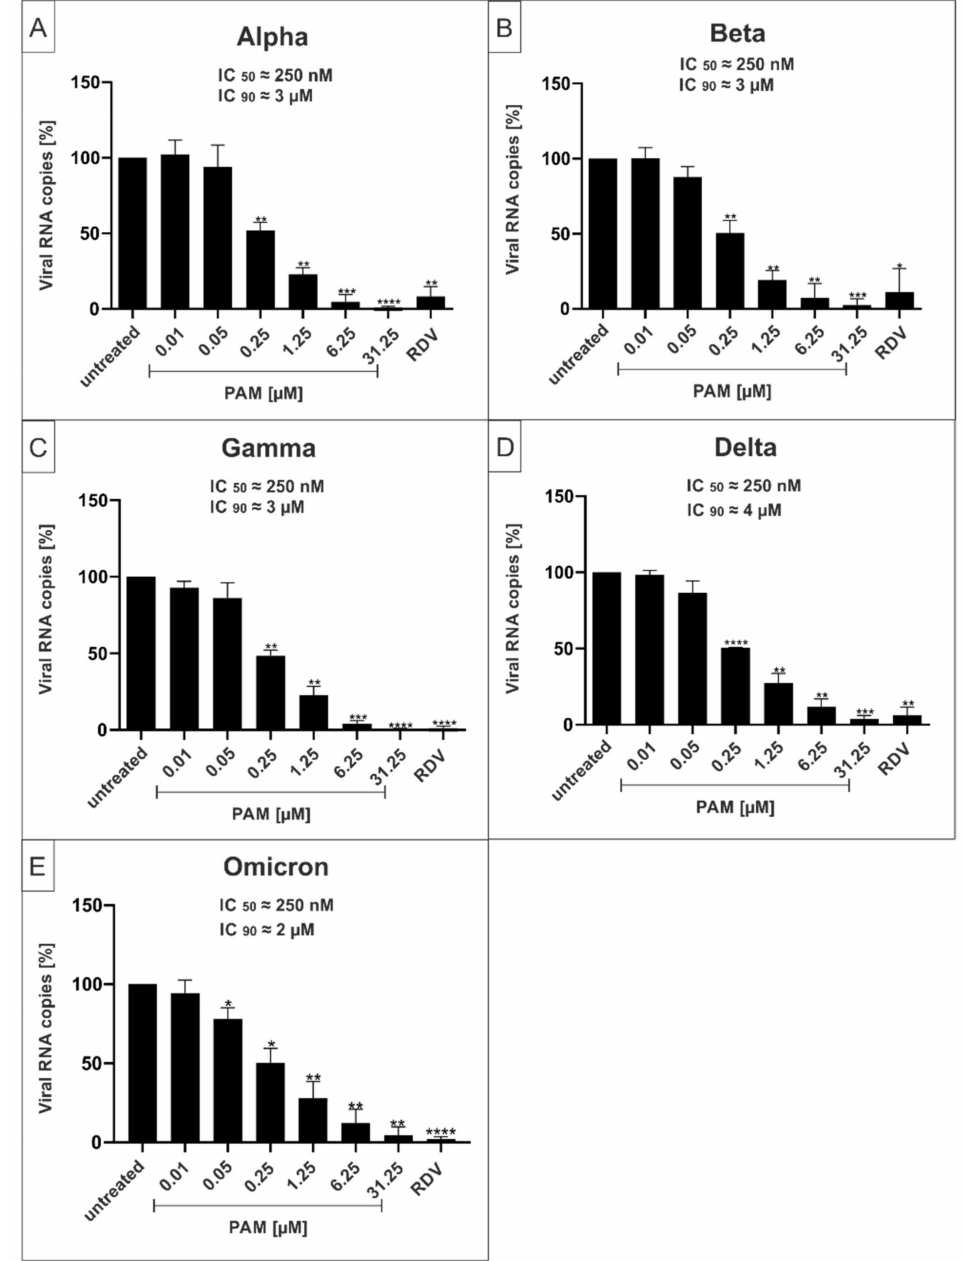
Figure 5. PAM inhibits replication of the SARS-CoV-2 Variants of Concern (VoCs) Alpha, Beta, Gamma, Delta, and Omicron with comparable antiviral efficacy. Calu-3 cells were infected with clinical isolates of the SARS-CoV-2 VoCs Alpha ( A ), Beta ( B ), Gamma ( C ), Delta ( D ), and Omicron ( E ) at a MOI of 2 × 10 − 2 . One hour after infection and removal of input virus, cells were treated with the indicated concentrations of PAM; 1 µ M RDV was included as a positive control. Cell culture supernatants were harvested at 3 dpi. The virions were purified and analyzed by qRT-PCR. Data represent means of three independent experiments ± standard deviation (* p < 0.05, ** p < 0.0089, *** p < 0.0008, and **** p < 0.0001) using a One sample t test, where each value is compared to the untreated